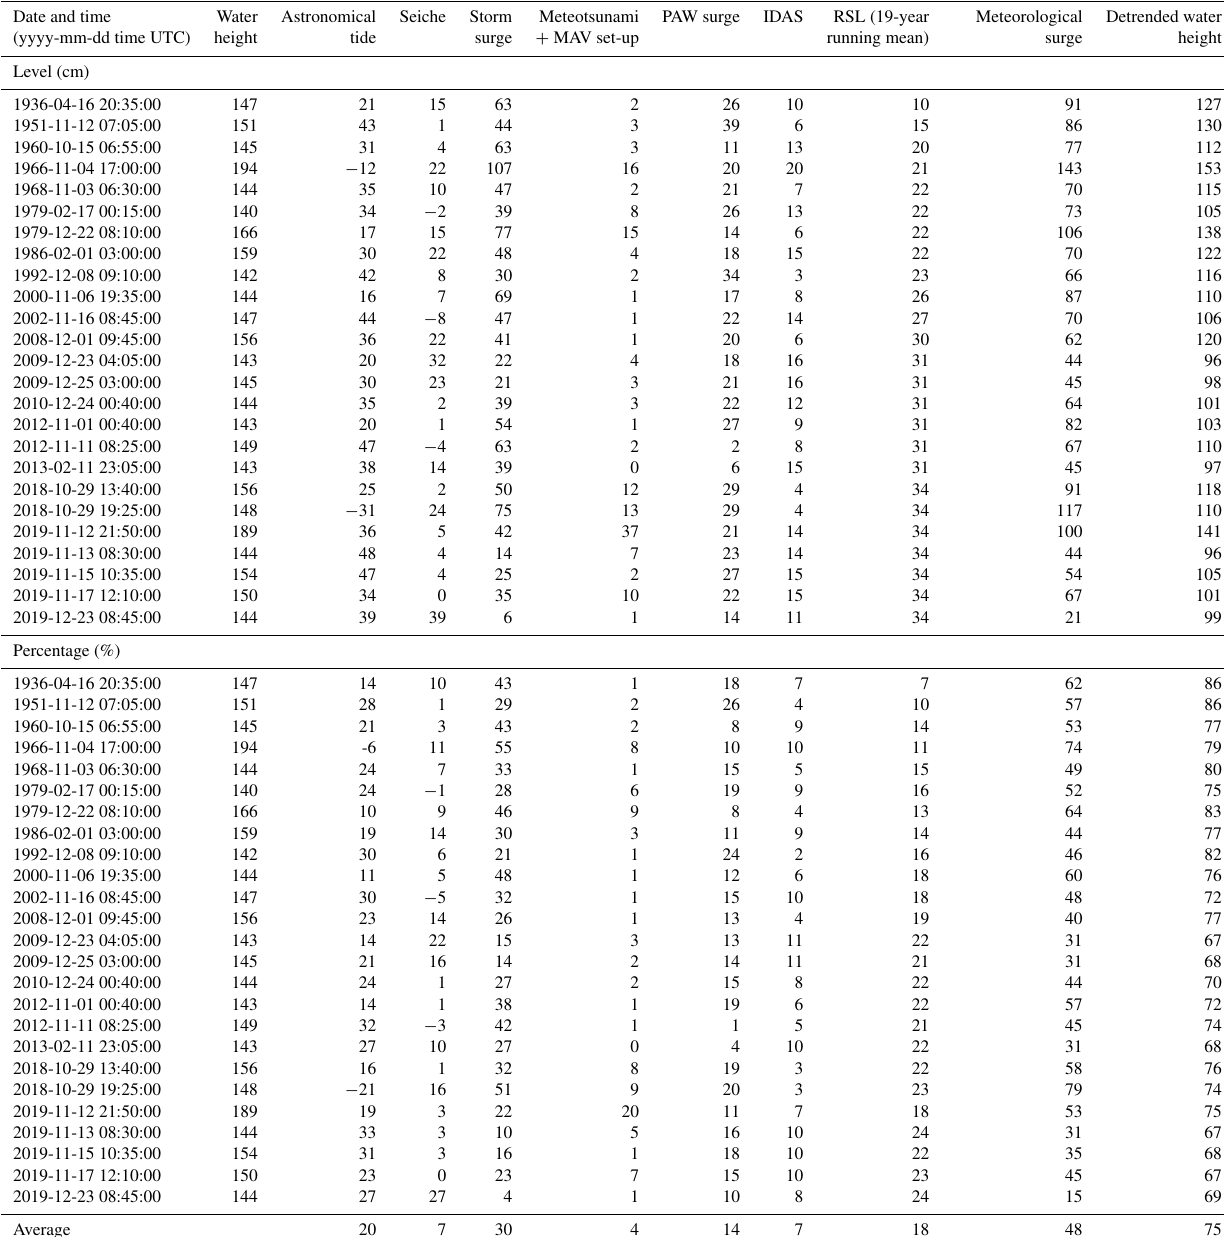
Table 1. List of the extreme water heights (higher than 140cm) alongside the contributions (see Sect. 2.1 and 2.2): astronomical tide, seiches, storm surge, meteotsunami and mesoscale atmospheric variability (MAV) set-up, PAW surge, IDAS variability, relative mean sea level, meteorological surge, and total surge. The water height values are referenced to the “Zero Mareografico Punta Salute” (ZMPS). The upper panel shows the actual values (cm), the lower panel the percentage (%) of each